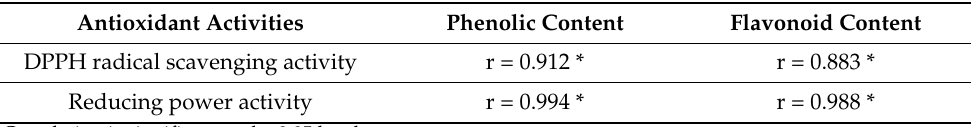
Table 2. Pearson’s correlation coefficients between the antioxidant assay and phytochemical analysis assay of P. australis